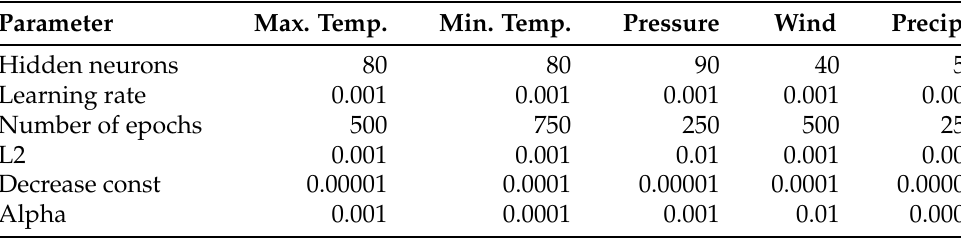
Table 5. The MLP hyperparameters as determined using a grid search.